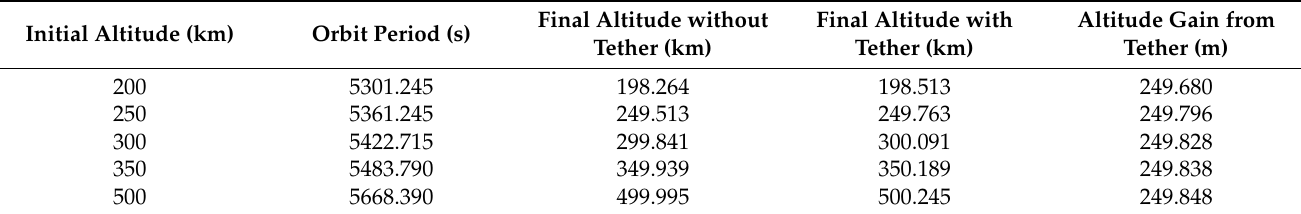
Table 6. Orbit and altitude parameters for implementation at various initial altitudes.